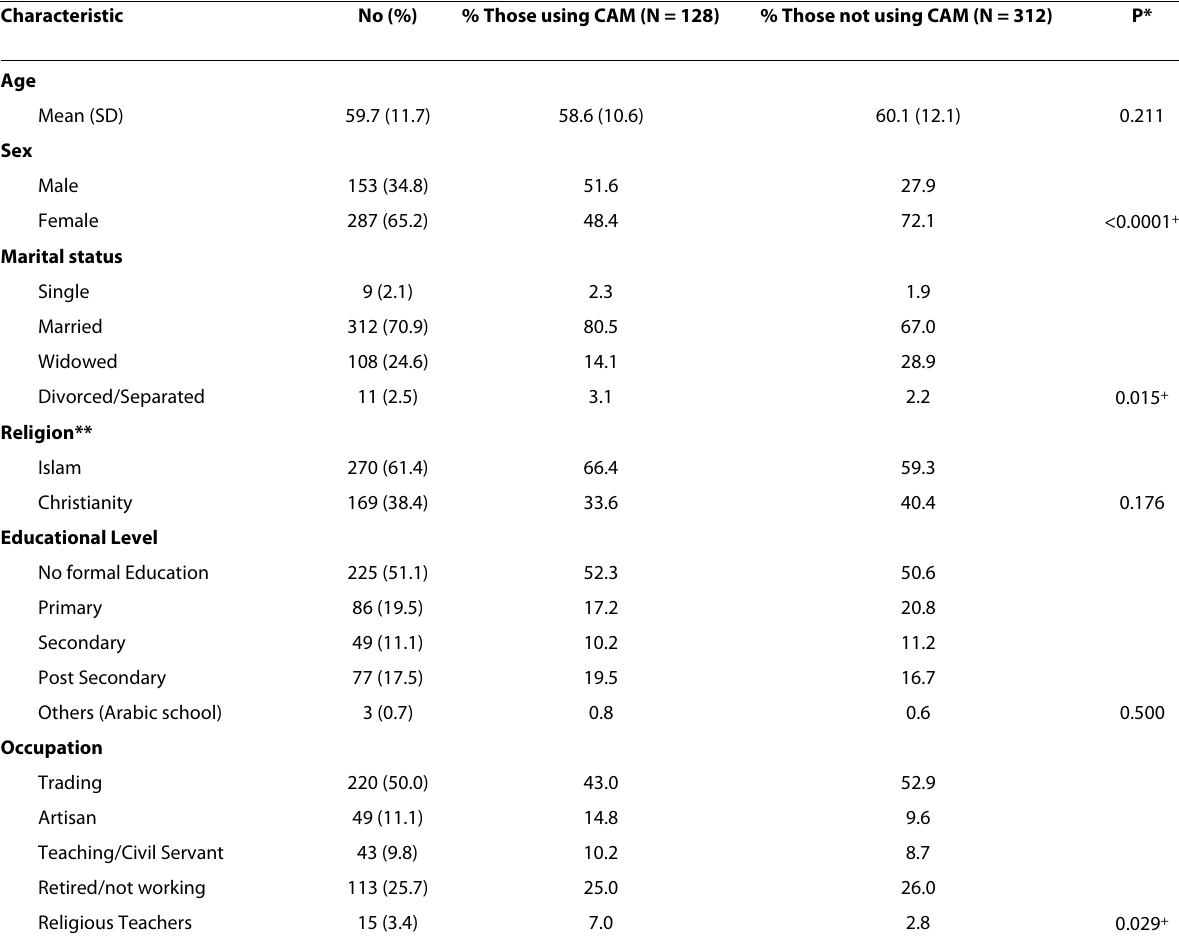
Table 2: Use of CAM by demographic characteristics of participants